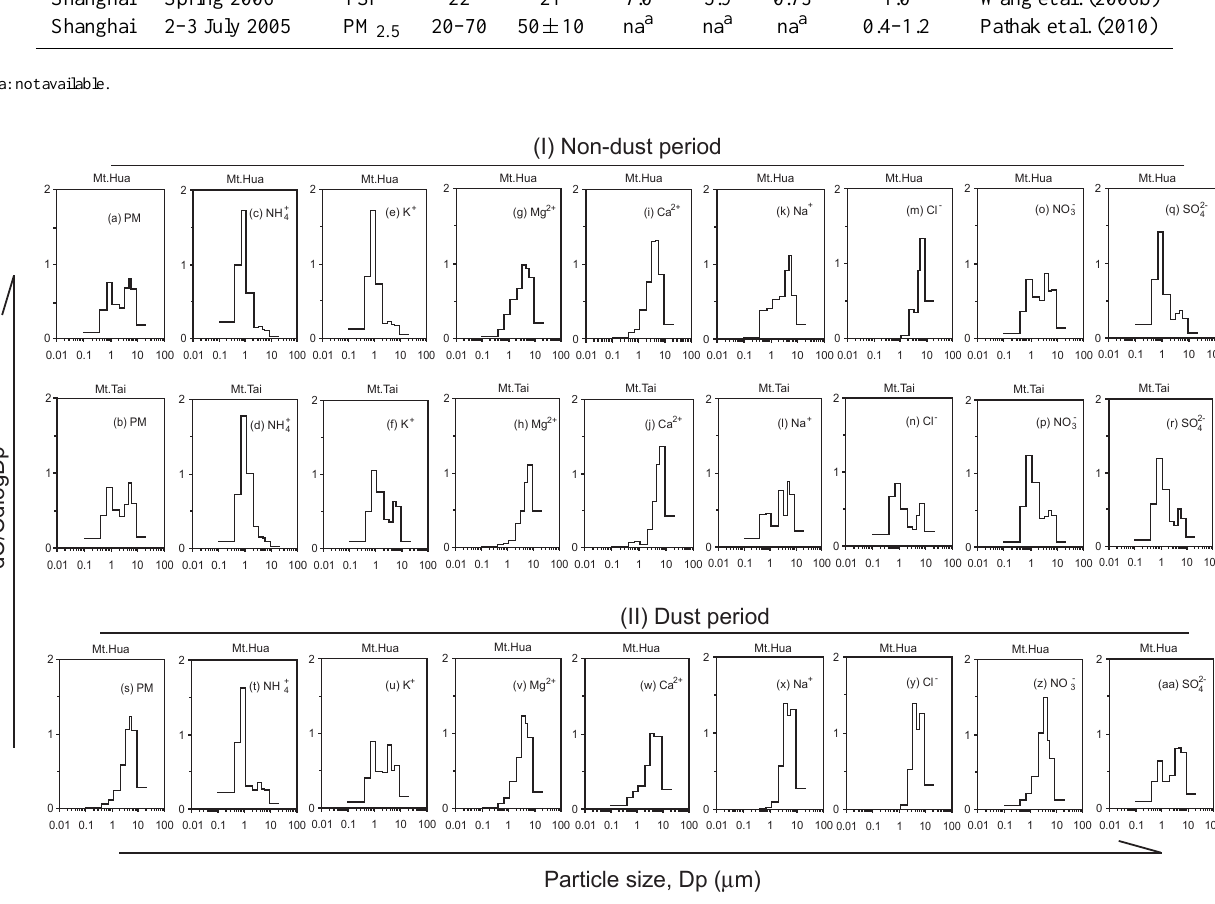
Fig. 10. Size distributions of particles and inorganic ions during (I) non-dust storm period and (II) dust storm Fig. 10 Size distributions of major ions in PM 10 during the non-dust period ((a-e) Mt. Hua and (f-j) Mt. Tai) and the dust period ((k-o) Mt.Hua)